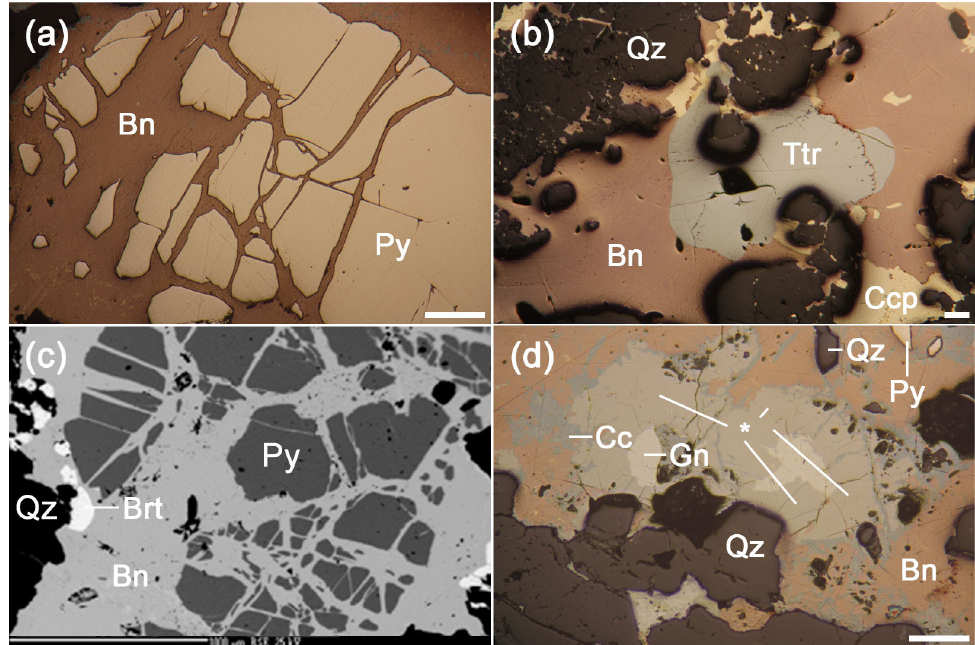
Figure 7. Plane-polarized reflected light photomicrographs and back-scattered electron images showing representative copper mineral assemblages from quartz-precompact copper: pyrite brecciated and cemented by bornite ( a ); bornite intergrowth with quartz and tetrahedrite inclusions ( b ); pyrite brecciated and cemented by bornite; barite at the border of bornite and quartz ( c ); intergrowth between bornite and the unnamed mineral; secondary replacement of chalcocite on cracks and at the border of unnamed mineral; inclusions of galena in the unnamed mineral ( d ). Bn—bornite; Py—pyrite; Ttr—tetrahedrite; Qz—quartz; Gn—galena; Cc—chalcocite; *—unnamed mineral, Brt -barite. Scale bars on the photomicrographs are 100 μm.